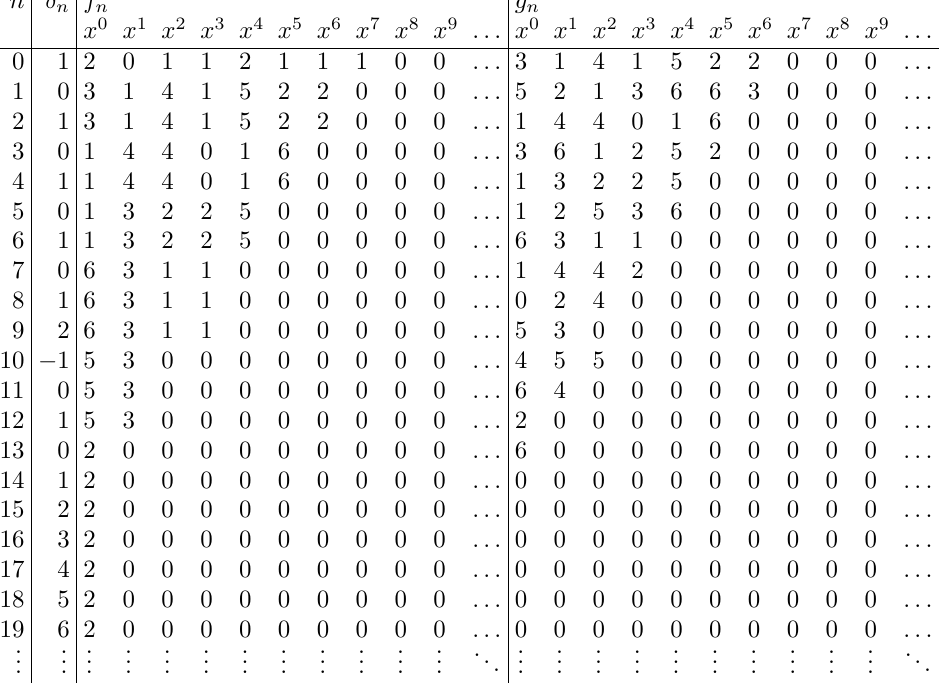
Table 4.1: Iterates ( δ n , f n , g n ) = divstep n ( δ, f, g ) for k = F 7 , δ = 1, f = 2 + 7 x + 1 x 2 + 8 x 3 + 2 x 4 + 8 x 5 + 1 x 6 + 8 x 7 , and g = 3 + 1 x + 4 x 2 + 1 x 3 + 5 x 4 + 9 x 5 + 2 x 6 . Each power series is displayed as a row of coefficients of x 0 , x 1 , etc. n δ n f